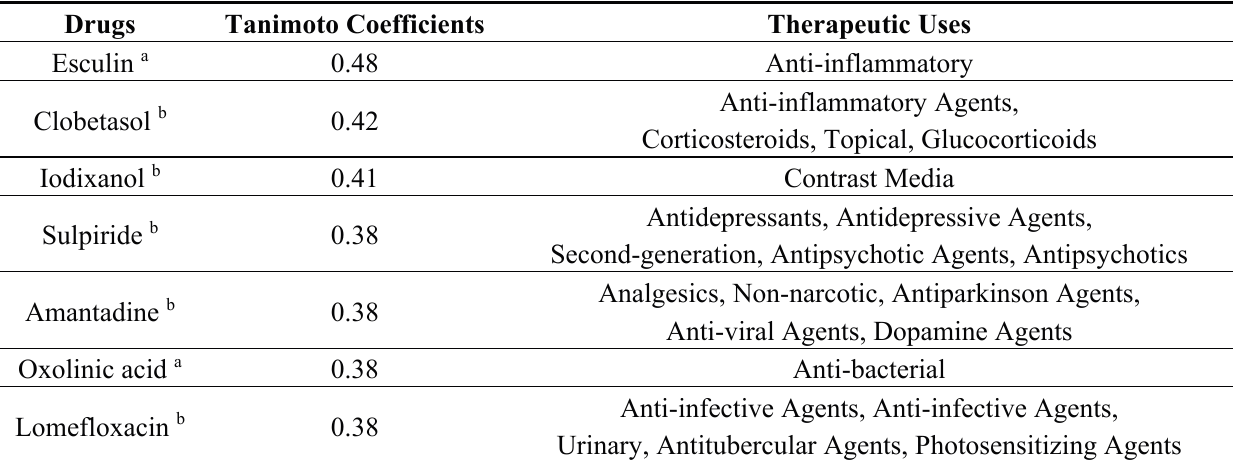
Table 1. Predicted similar drugs to curcumin.